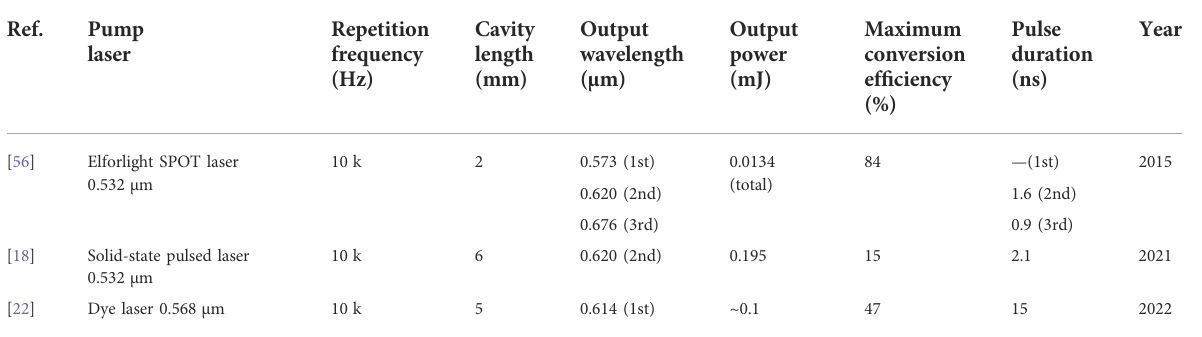
TABLE 6 Summary of microcavity ns-pulsed DRLs. Ref.